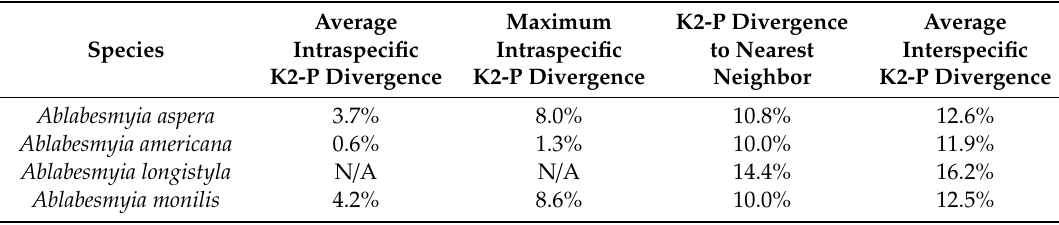
Table 3. Intra- and interspecific Kimura 2-parameter distances between Ablabesmyia species defined by morphology. N / A denotes species with only one specimen